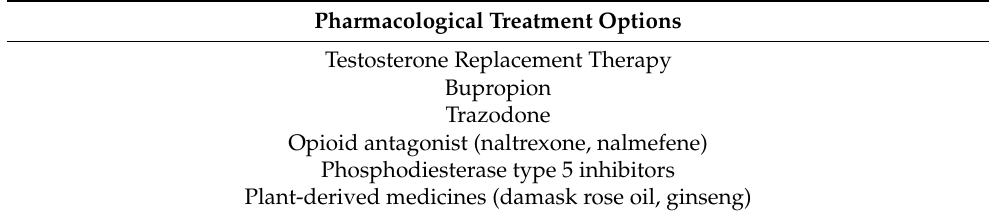
Table 3. Pharmacological treatment options for opioid-induced sexual